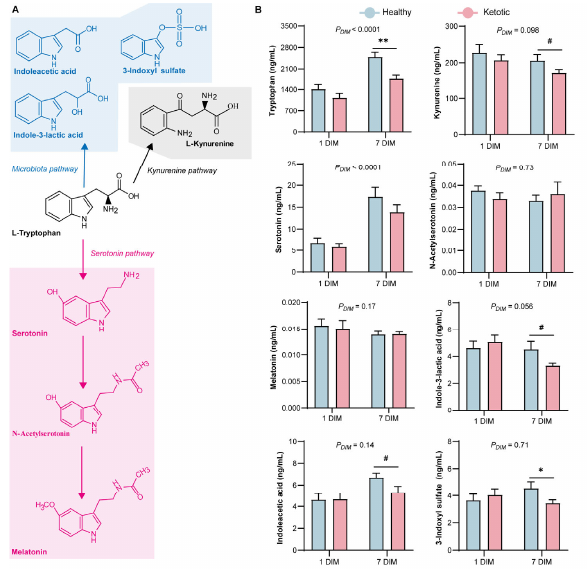
Figure 2. Tryptophan (Trp) metabolism in dairy cows during the ketosis event. ( A ) Diagram of Trp metabolism pathway, including kynurenine, serotonin, and microbiota pathways. ( B ) Levels of Trp and its main metabolites between the healthy and ketotic groups at 1 and 7 days in milk (DIM). 0.05 ≤ # p < 0.1, * p < 0.05, and ** p < 0.01.